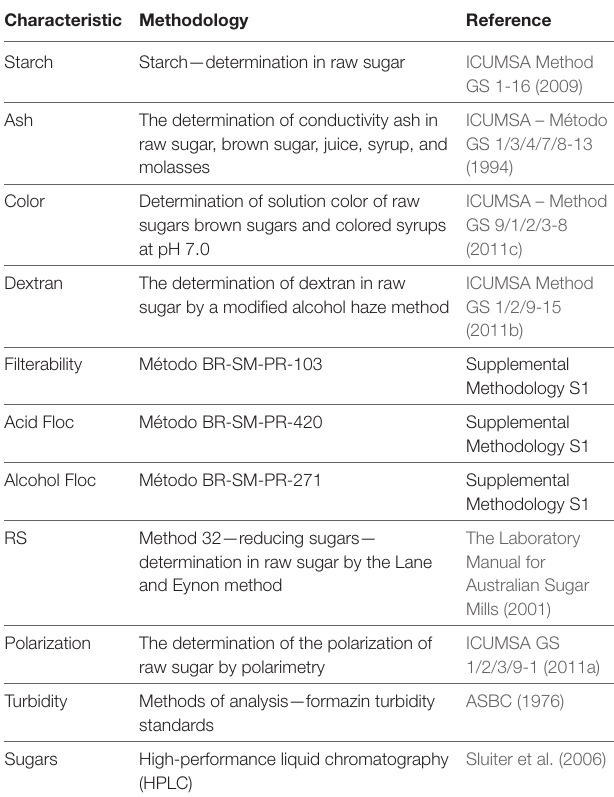
TaBle 1 | Methodologies used for analyzing characteristics used for sugar classification in Brazilian